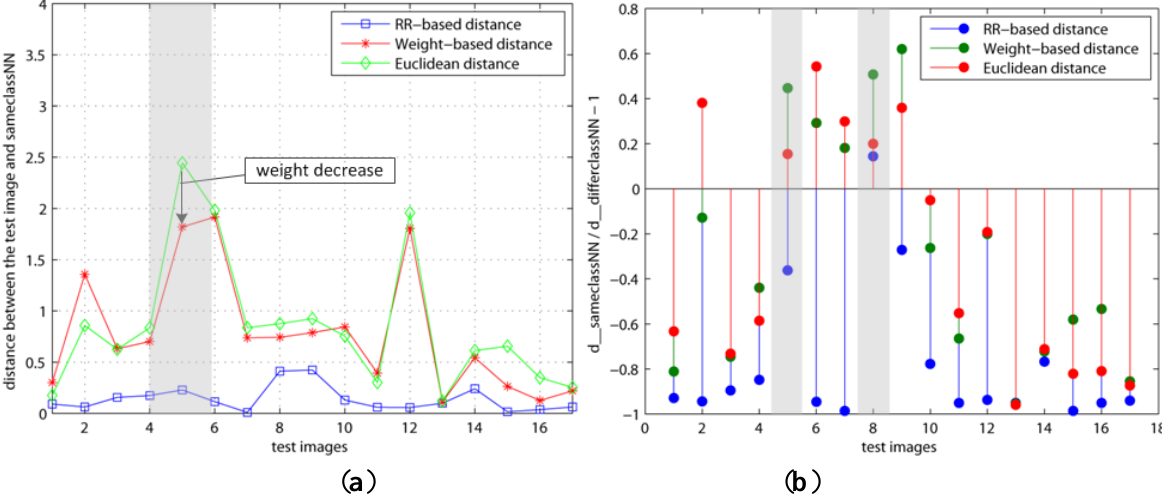
Figure 5. Variation of weights using Euclidean, weighted-based and RR-based distance